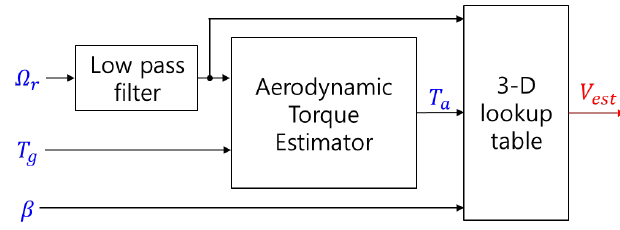
Figure 7. Block diagram of wind estimator.